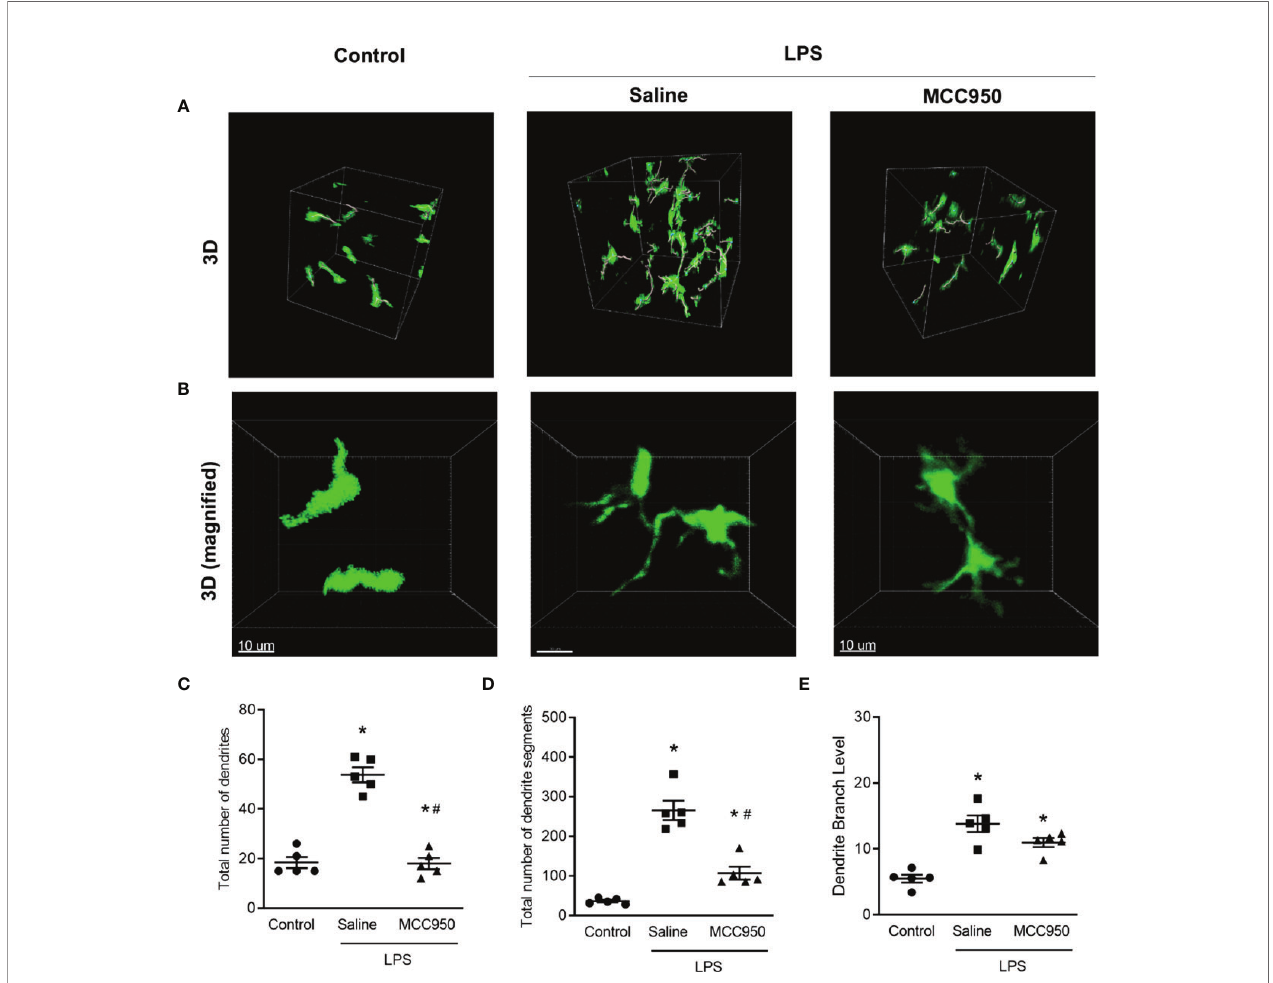
FIGURE 5 | Morphometric analysis of dendrites of CD11c+ cells in the LPS-induced AKI model. (A) Three-dimensional MPM image. The lines in cell bodies represent the tracings for dendrite segments. (B) Magni fi ed images of individual cells in the selected area. (C) Total number of dendrites. (D) Total number of dendrite segments. (E) Dendritic branch levels. Data are represented as the mean ± SEM (n = 5 per group). * P <0.05 versus the normal control, # P <0.05 versus the saline-treated LPS